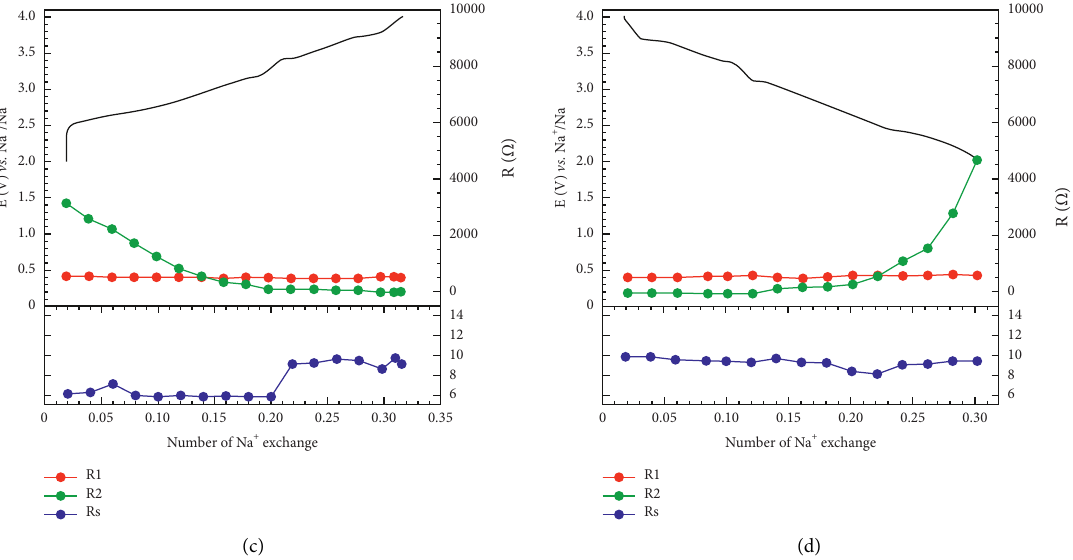
Figure 8: Nyquist plot of NaNMC cathode batteries in charging (a) and discharging (b). The evolution of semicircle resistances Rs, R 1, and R 2 in charging (c) and discharging